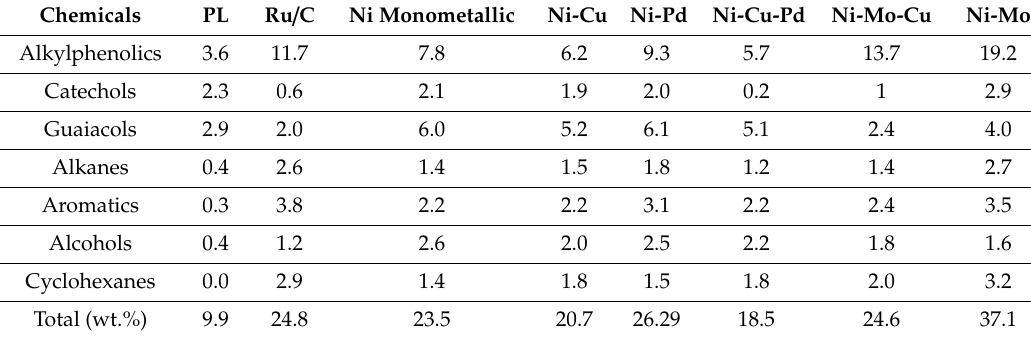
Table 6. GC × GC of PL and hydrogenated product